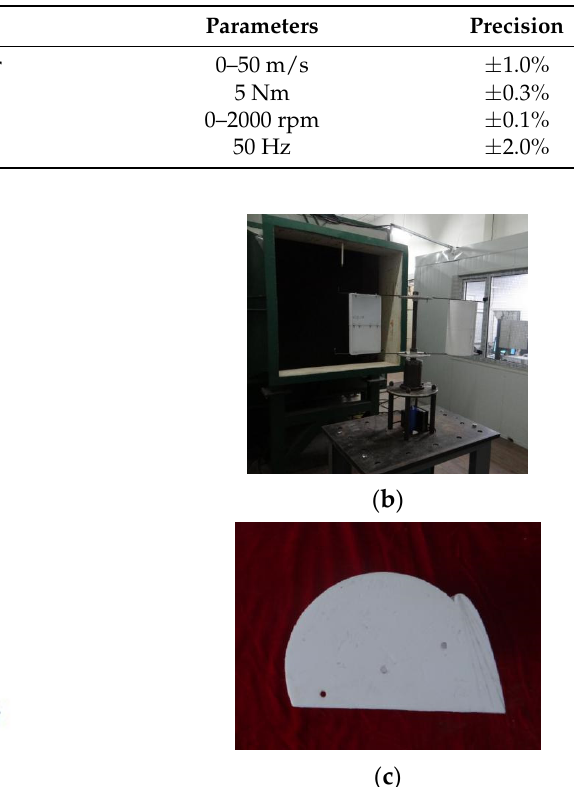
Table 2. Equipment parameters and accuracy table.